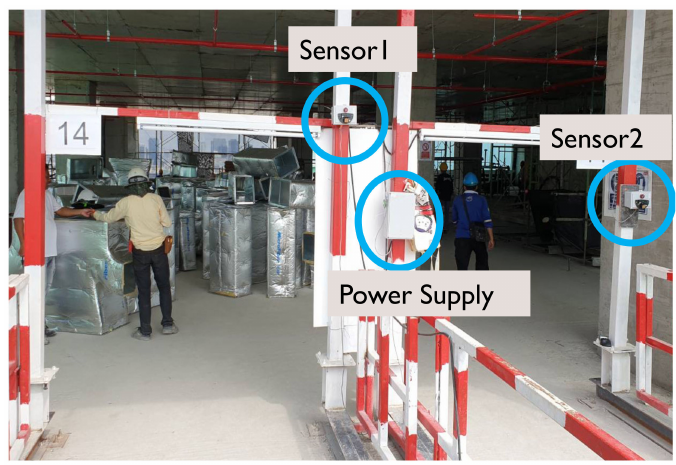
Figure 5. Sensors